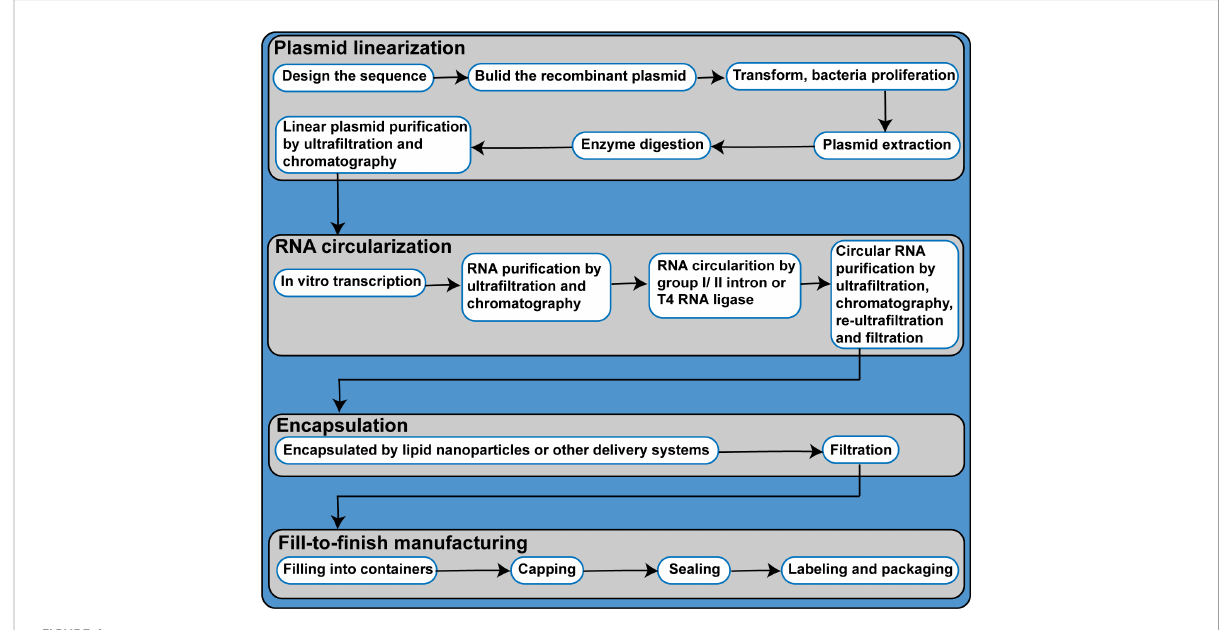
FIGURE 4 Process fl ow diagram of circRNA vaccine